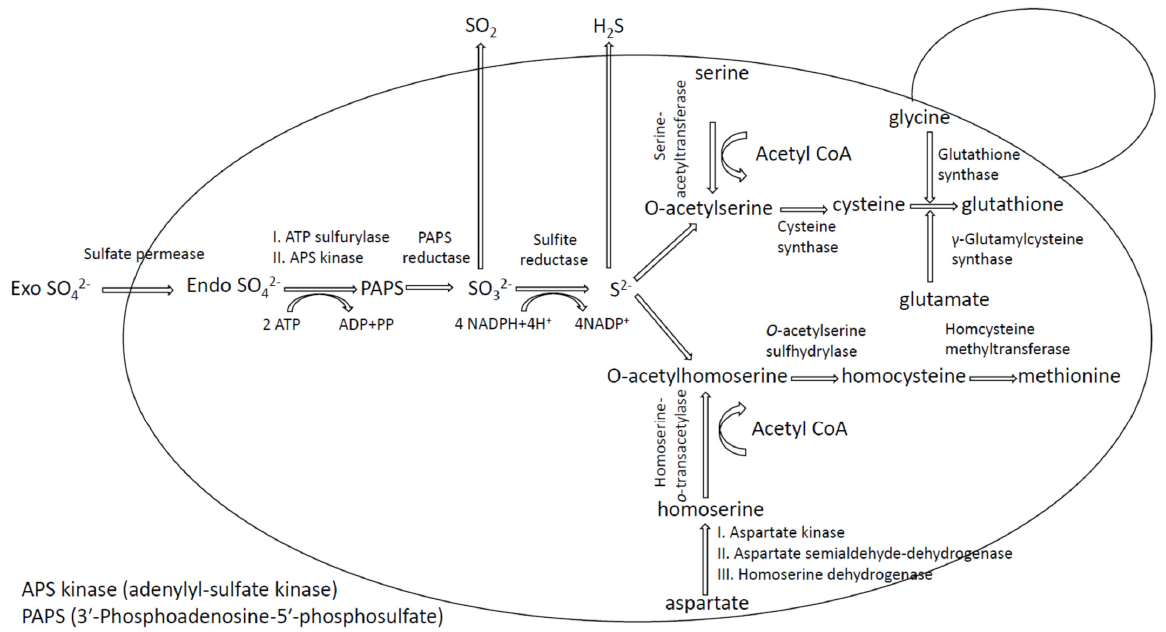
Figure 2. Formation of sulphur compound by yeast.